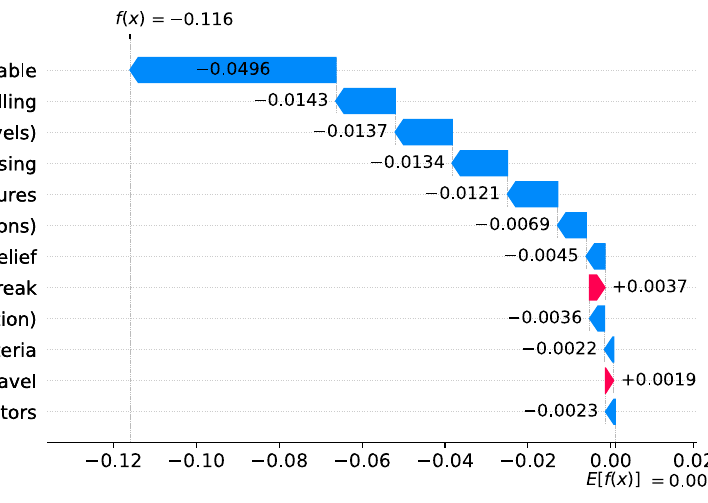
Fig 19. (Color online) factors driving acceleration in the UK on the 38 th day.